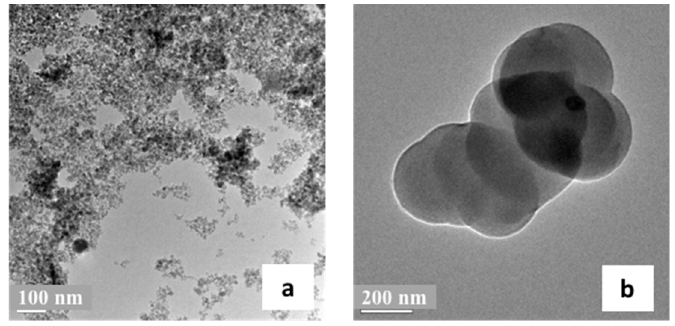
Figure 3. Transmission electron microscopy (TEM) images of Fe 3 O 4 ( a ) and MIIP ( b ).